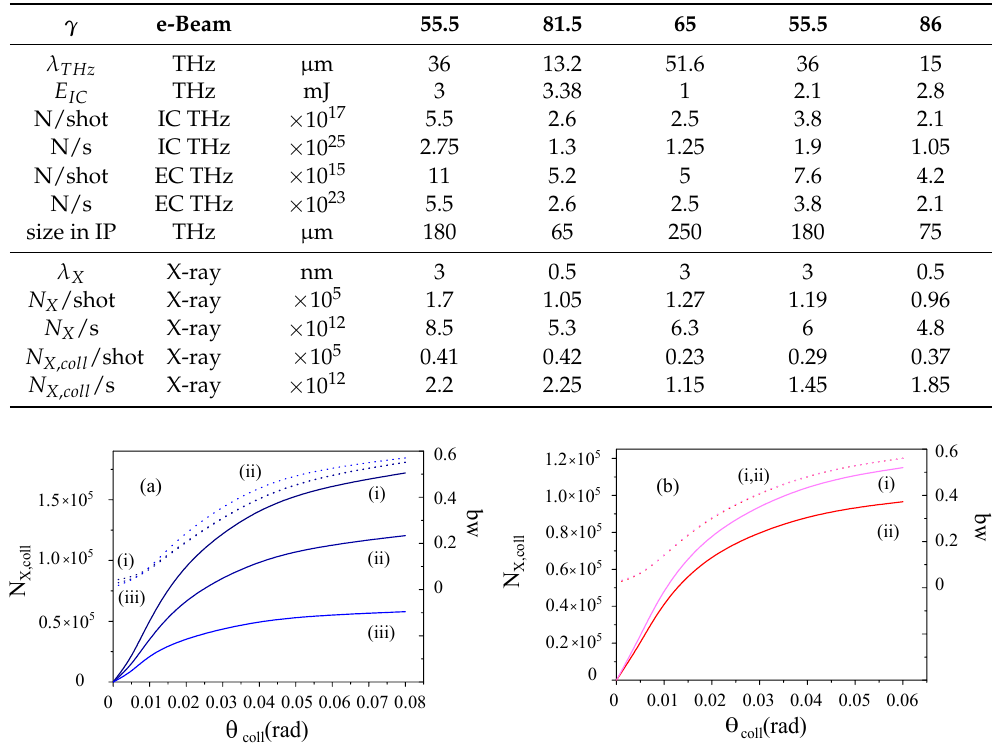
Table 4. X-ray radiation: electron energy, pump characteristics, results. Repetition rate of the source 5 × 10 7 Hz. IC: intra-cavity, EC: extra-cavity.